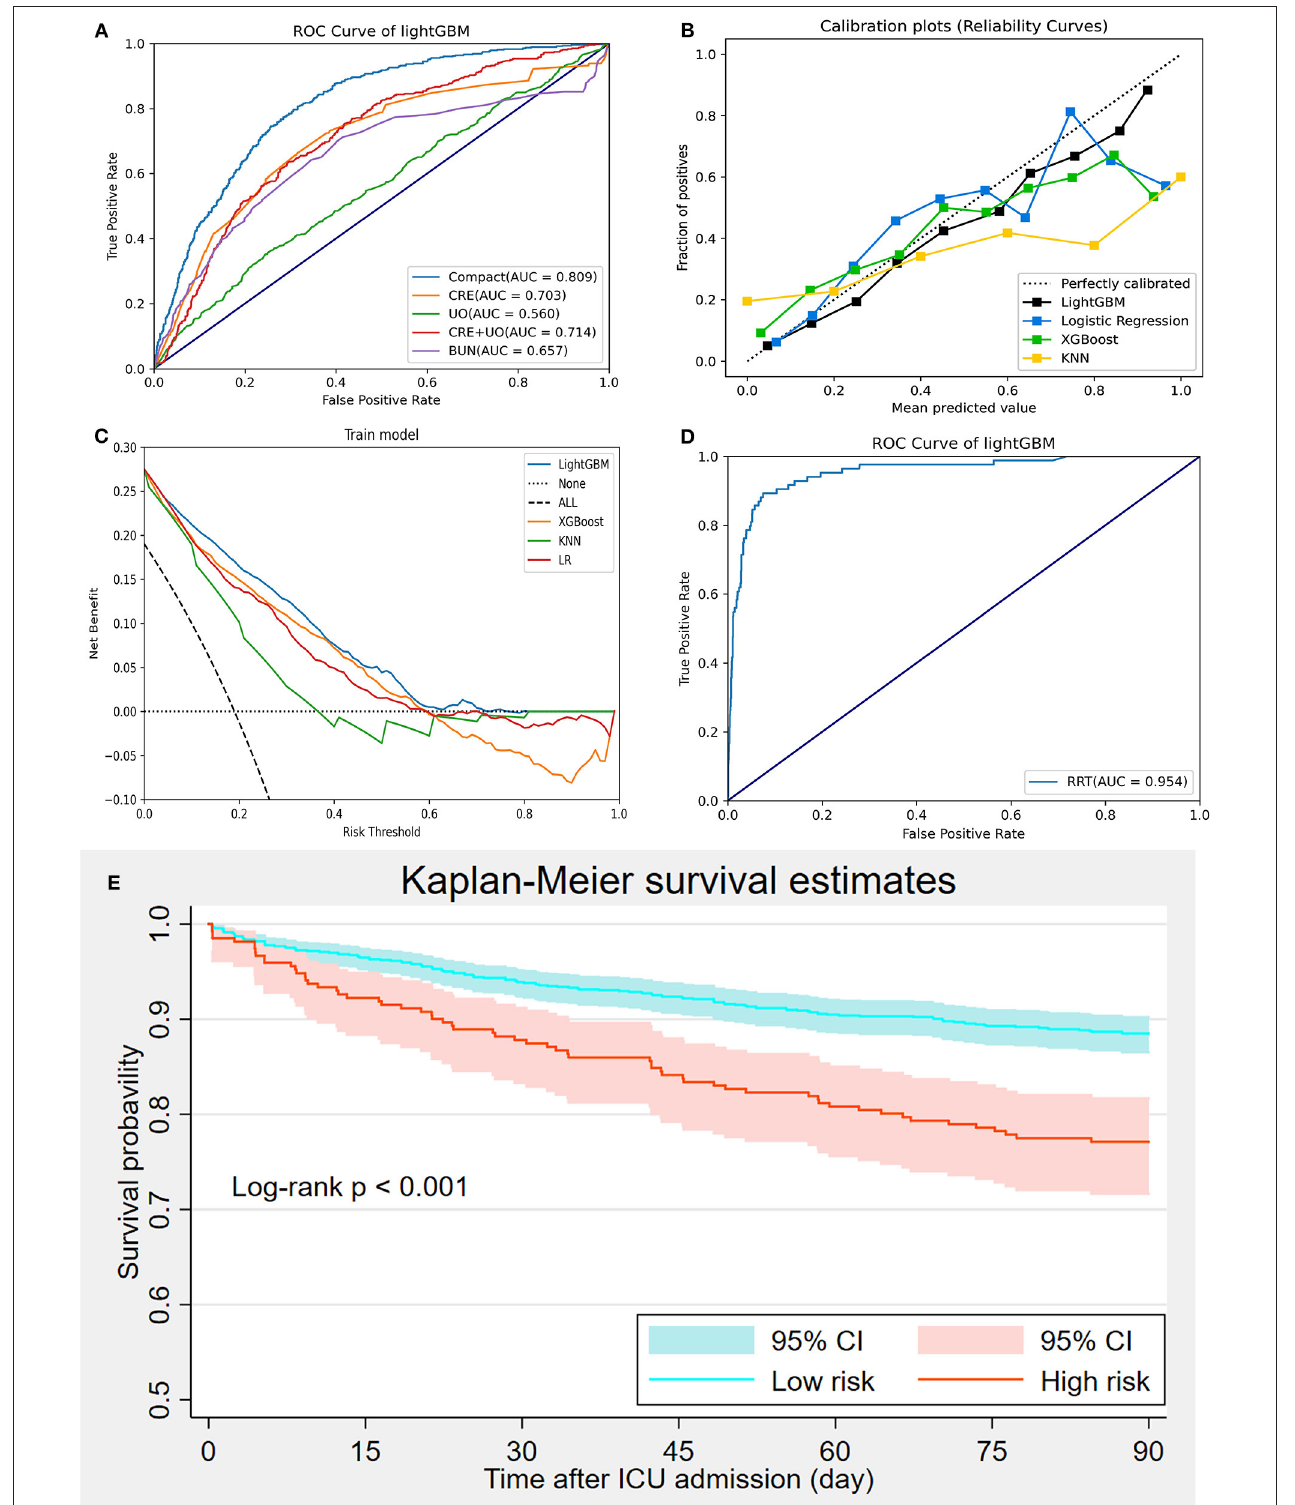
FIGURE 6 | Model evaluation and validation. (A) Comparisons of prediction performance between the compact model and measurements of creatinine, urine output, creatinine combined with urine output, and urea nitrogen; (B) Calibration curve; (C) Decision curve analysis; (D) Prediction of renal replacement therapy requirement using the LightGBM model; (E) Kaplan-Meier curve analysis of 90-day mortality between high-and low-risk groups divided using the LightGBM.